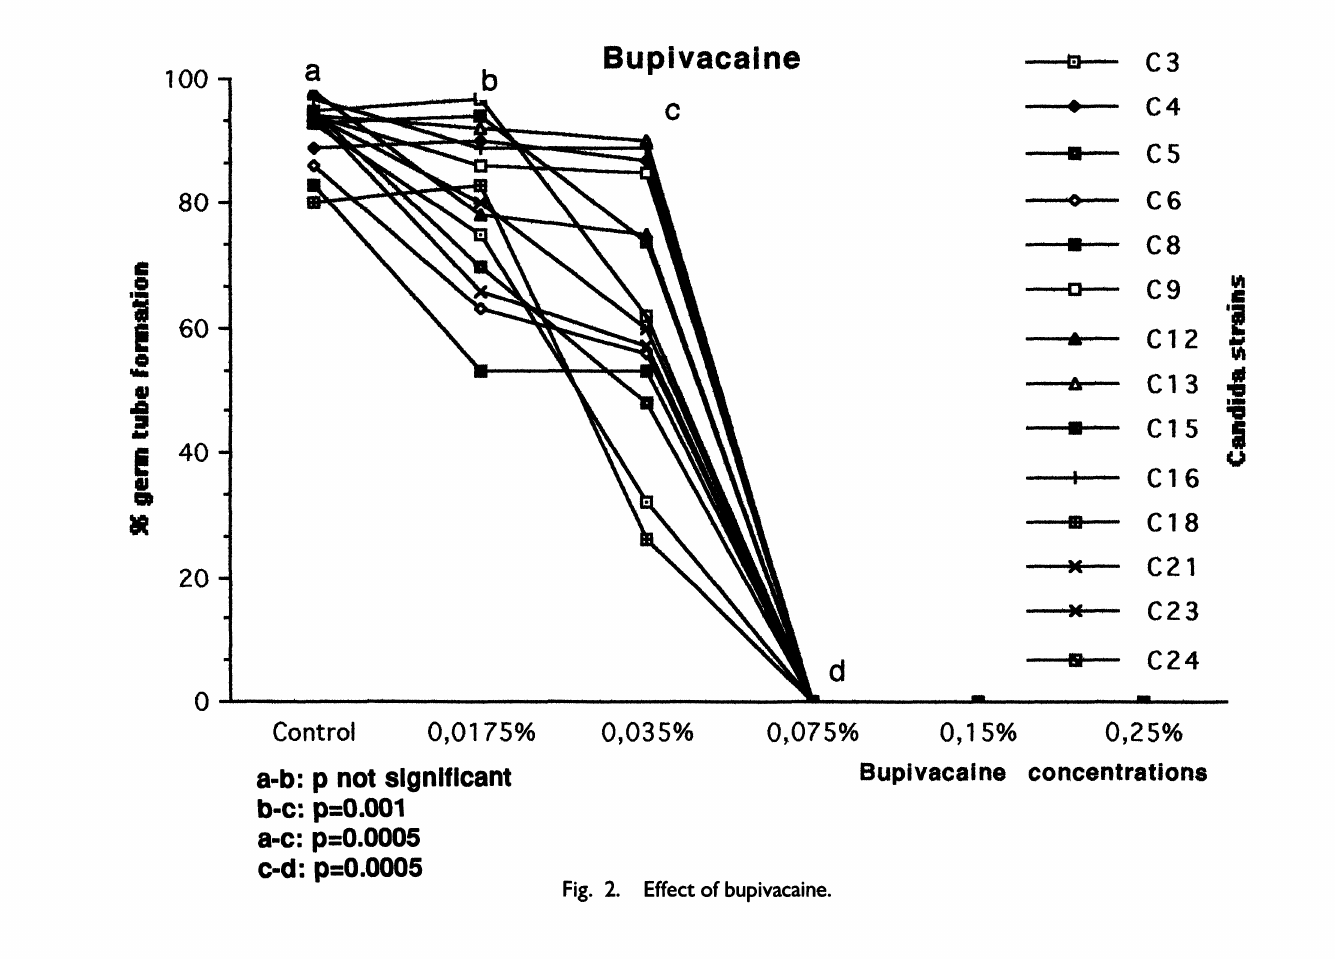
Fig. 2. Effect of